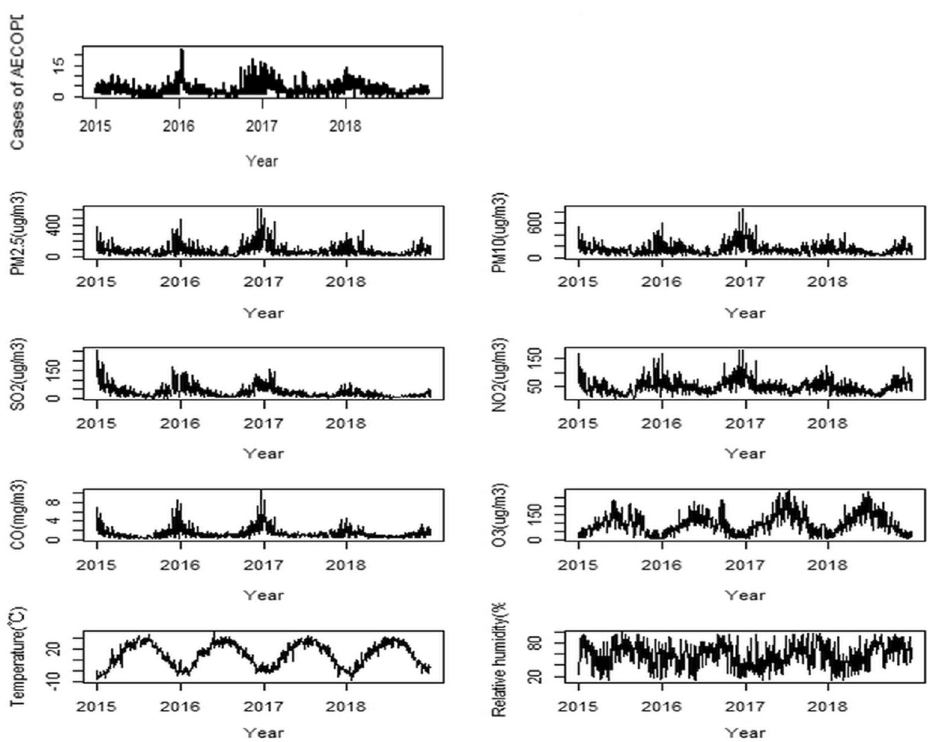
Figure 2. The distribution of the daily AECOPD cases, daily mean air pollutants and meteorological variables in Shijiazhuang, China, 2015–2018.